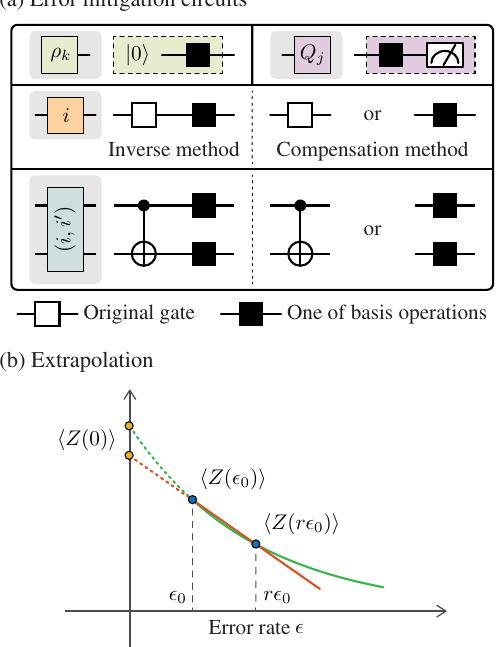
FIG. 2. (a) Error mitigation circuits. The choice of a basis operation is determined by the corresponding random number i , j , or k . Original gate that is identity (memory operation) also has to be error mitigated, unless memory error is negligible. In the compensation method, either the original gate or basis operations are applied depending on the random number. (b) The schematic of the linear extrapolation (orange curve) and exponential extrapolation (green